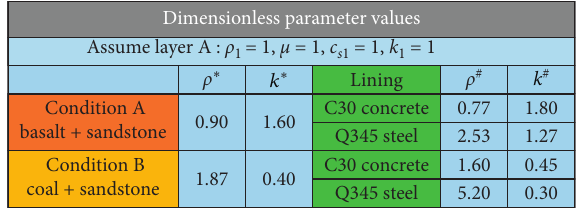
Figure 5: Dimensionless parameters of composite strata and